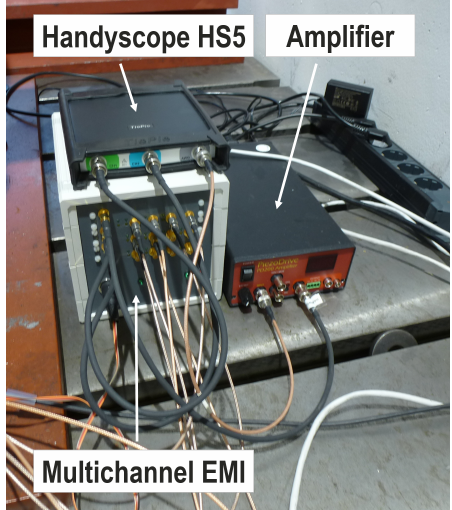
Figure 4. ( a ) Photo of the experimental setup showing the rudder stock in the test stand. ( b ) Positions of the piezoelectric transducers around the circumference.